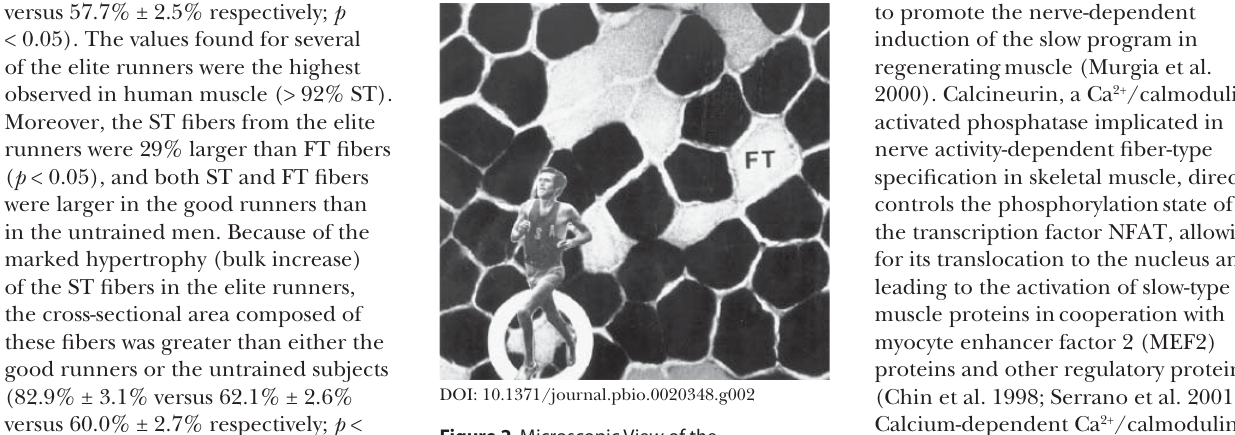
Figure 2. Microscopic View of the Gastrocnemius Skeletal Muscle from a World- Class Marathon Runner, Frank Shorter (Olympic Gold Medalist, 1972; Olympic Silver Medalist, 1976) The darkly stained fi bers are relatively slow in contractile rate and are ST. These fi bers demonstrate a higher aerobic (oxidative) capacity and a lower anaerobic (glycolytic) potential than the lighter stained FT fi bers. Shorter’s muscle contains approximately 80% ST fi bers. Reproduced with kind permission from David L. Costill and William J.